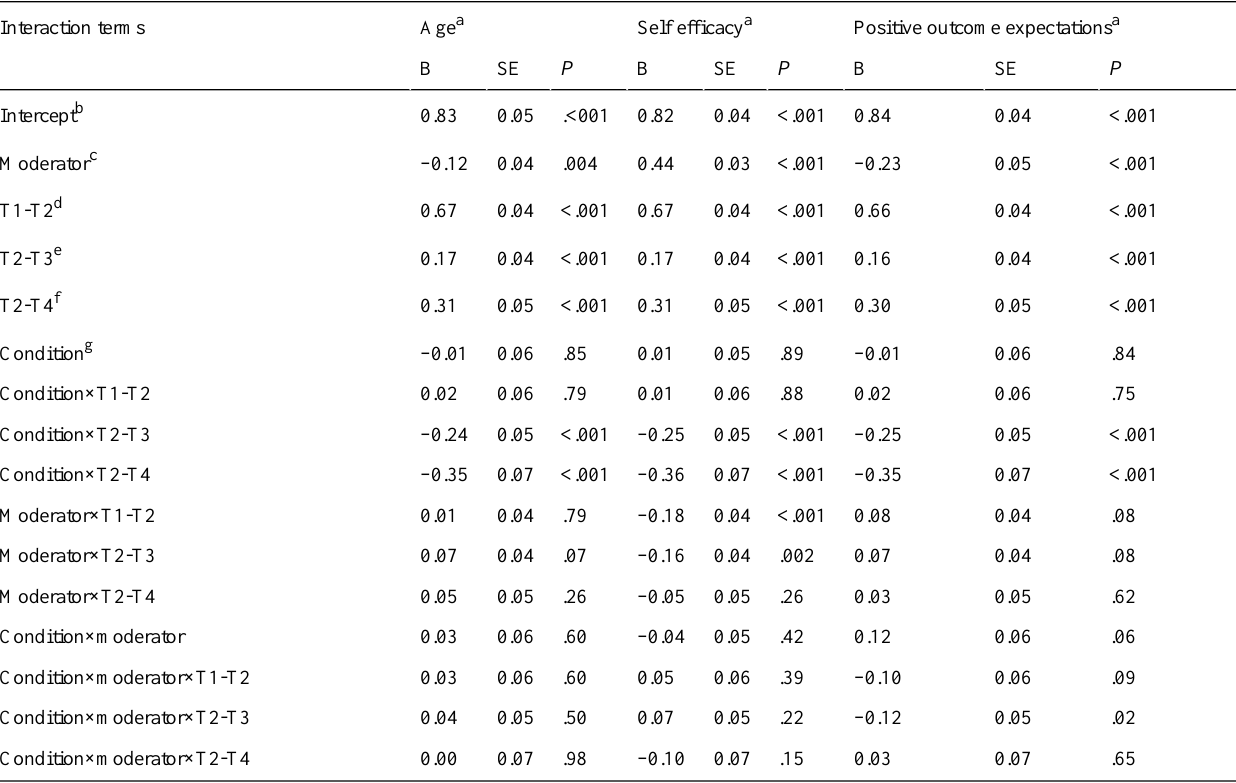
Positive outcome expectations a Self efficacy a Age a Interaction terms P SEB P SEB P SEB